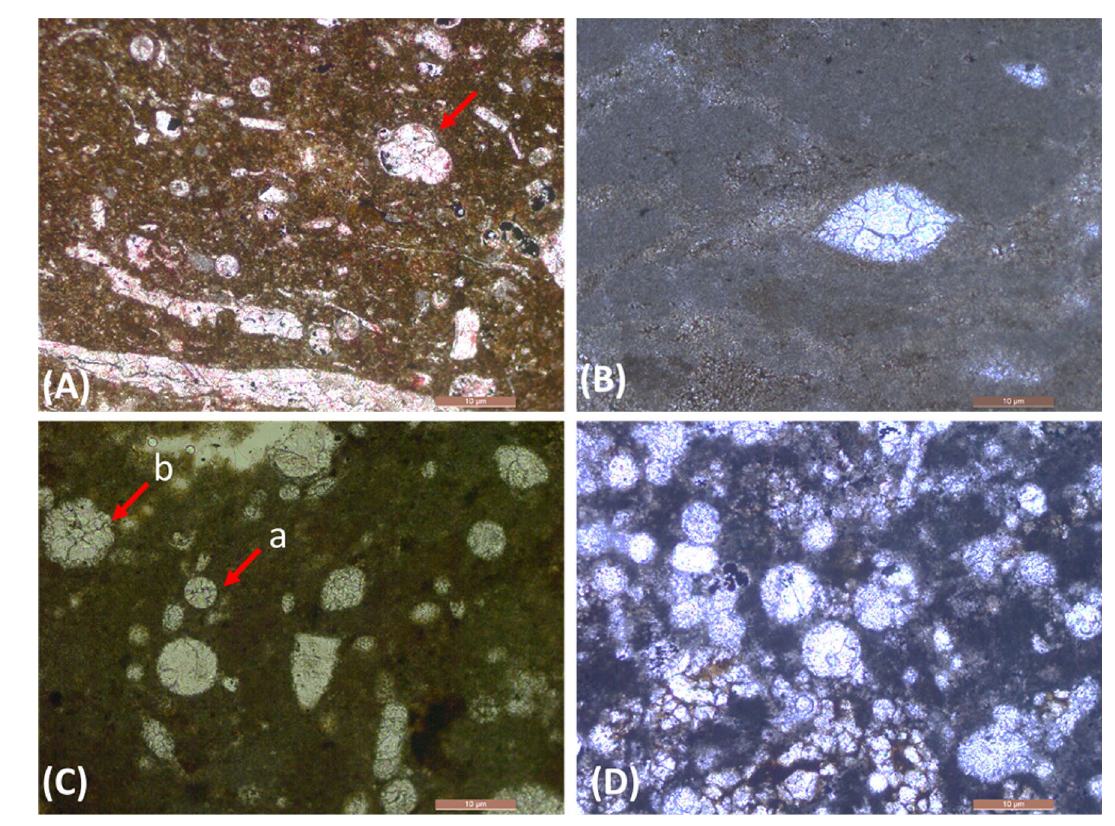
Fig. 6 a Planktonic Forams (Globigerina) in micrite matrix, chamber partially bearing pyrite (arrow), Bk-38, P.P., b Articulated ostracods filled with granular cement, in micritic matrix, Bk-1, P.P. c Calci- sphere filled with calcite (a) and associated with radiolaria (b), gen-